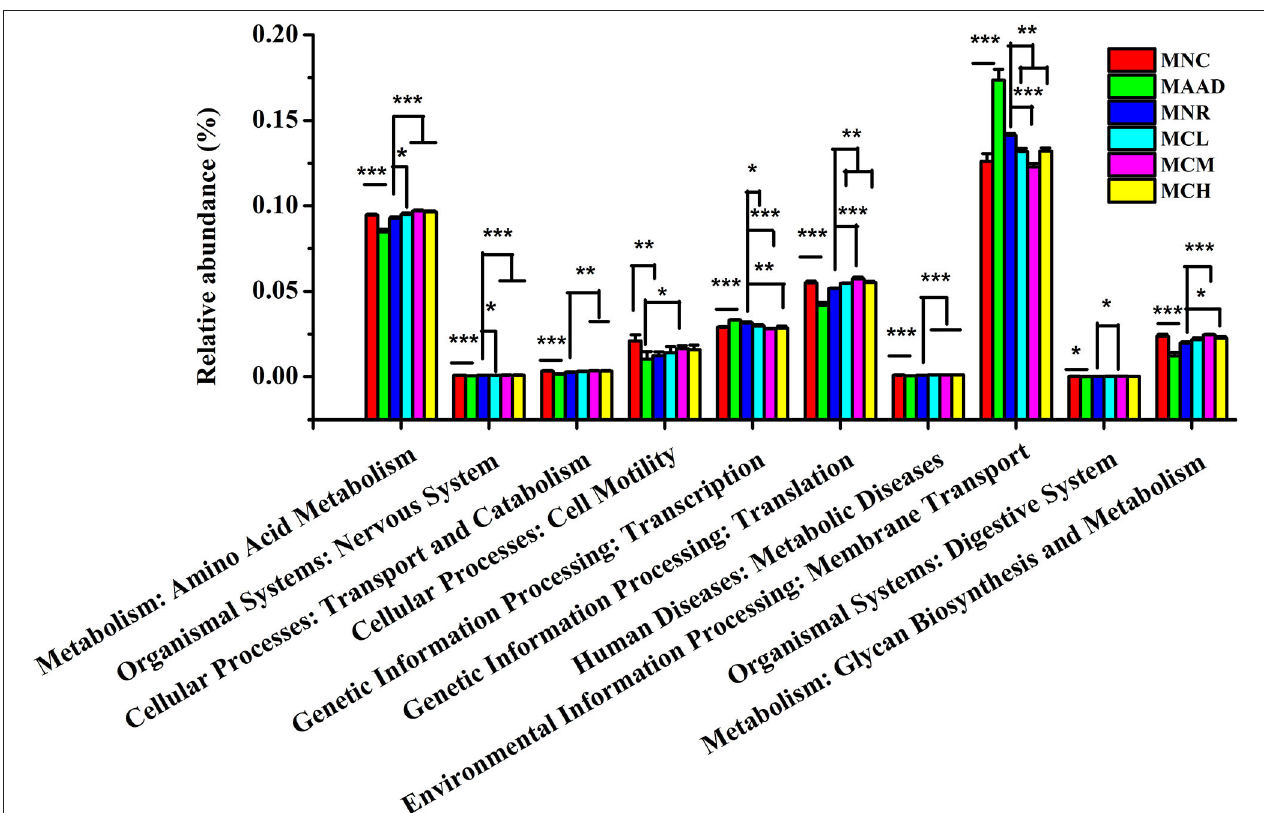
FIGURE 7 | Prediction of metabolic function by PICRUSt analysis. Values are shown as means ± SD. Different letters are significant differences. * p < 0.05, ** p < 0.01, *** p <